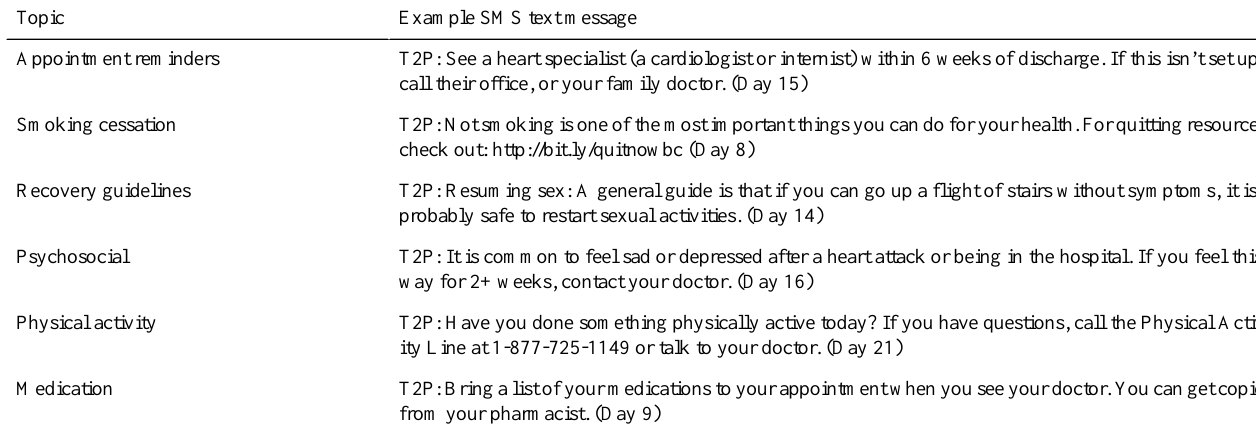
Table 1. Examples of the SMS text messages in the intervention group (Txt2Prevent). Example SMS text